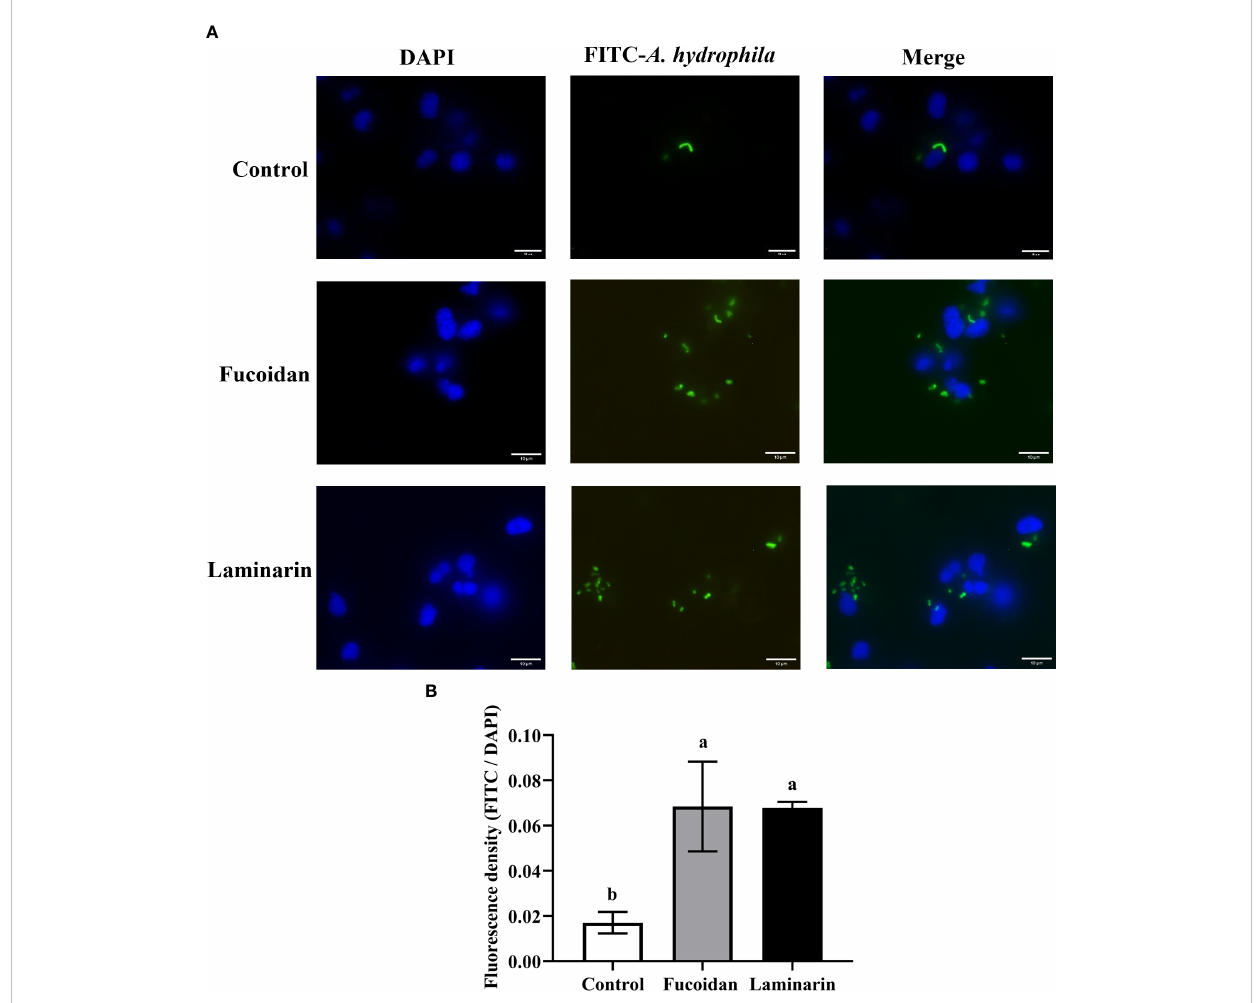
FIGURE 1 Fucoidan and laminarin increase the phagocytic capacity of macrophages against FITC-labeled A. hydrophilus. (A) For visual analysis, cells were fi xed with 4% paraformaldehyde for 10 min and the nuclei were stained with DAPI, then imaged using a fl uorescence microscope. The 3 columns of images represented the nuclei of macrophage stained with DAPI (blue), phagocytized FITC-labeled A. hydrophila (green), and the merged images, respectively. (B) Quanti fi cation of seaweed polysaccharides-induced phagocytosis, different alphabets indicate signi fi cant differences (P > 0.05). Scale bars = 10 m